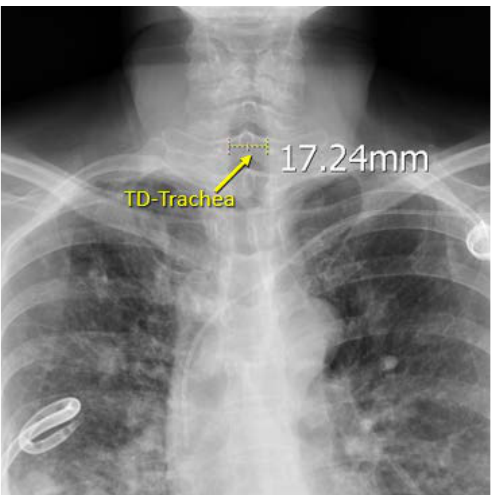
Figure 6. Measuring of the patient’s TD-Trachea, performed at the mid body of C7 on chest X-ray.